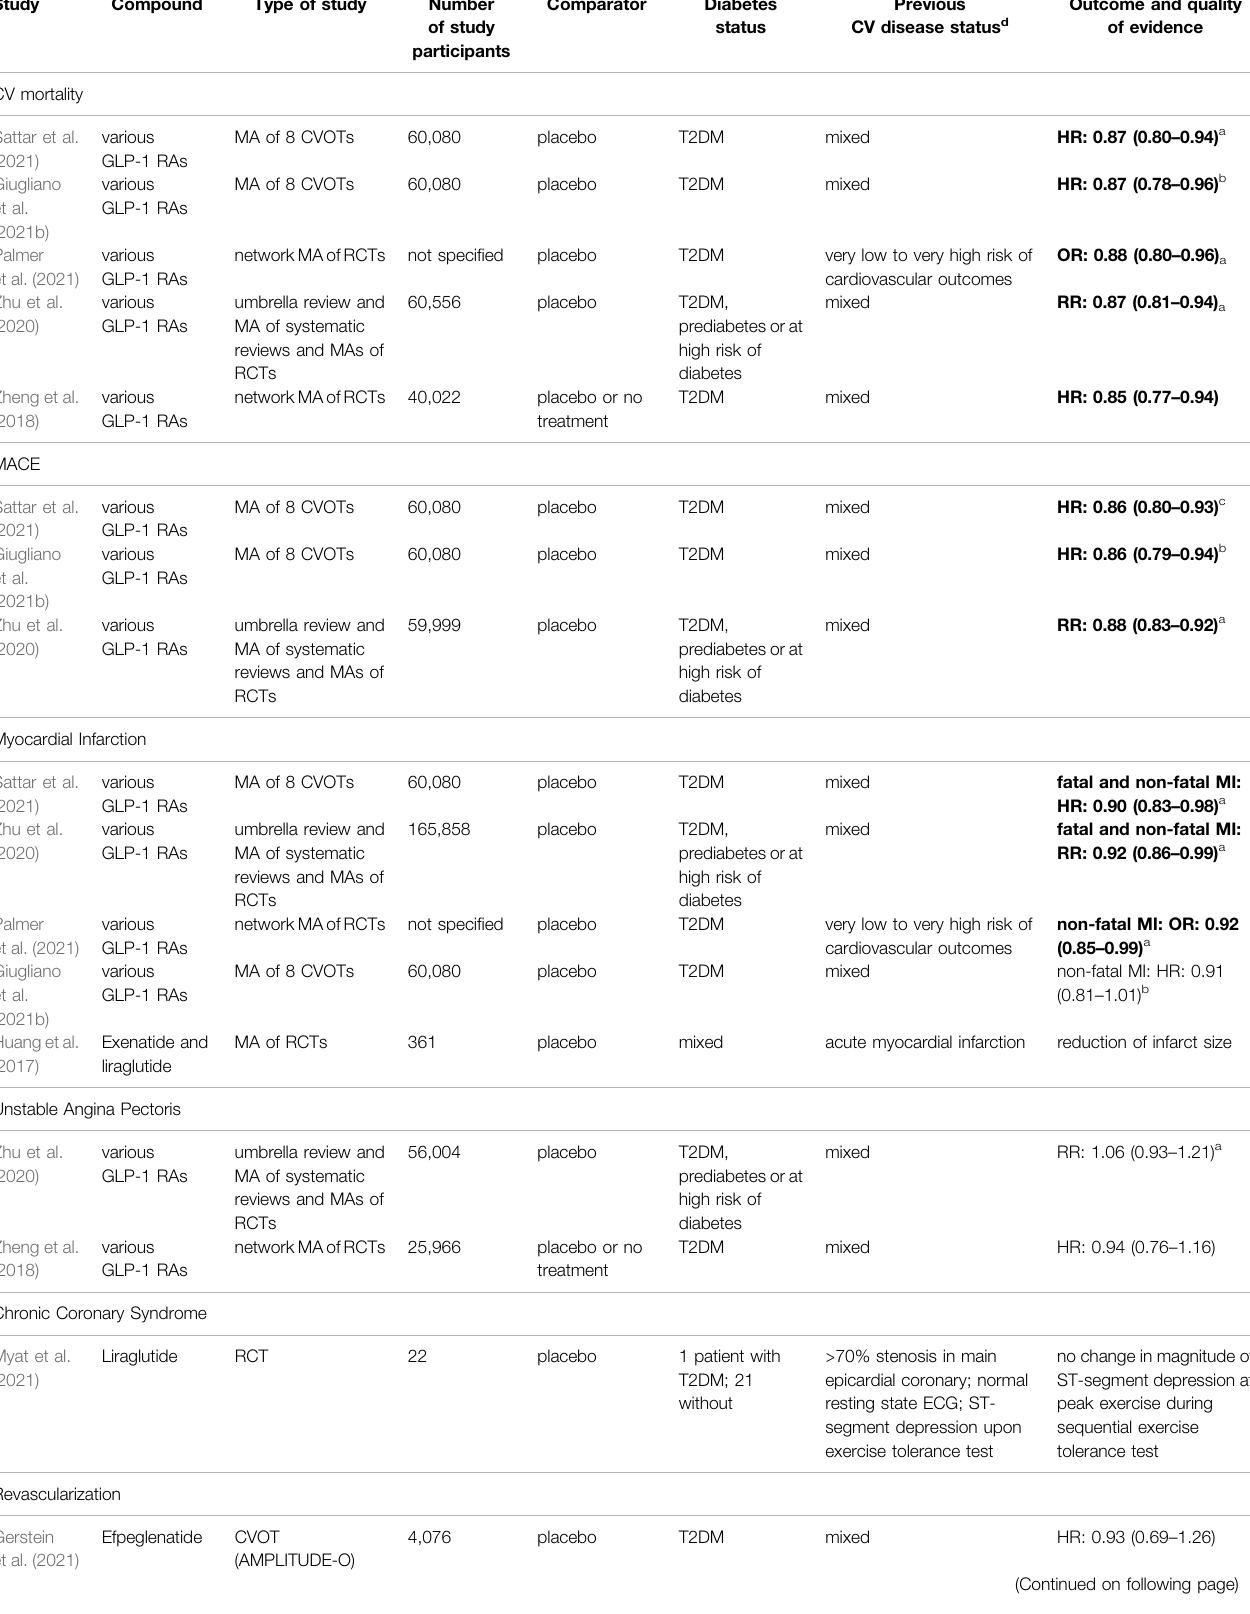
TABLE 2 | Overview of studies reporting on GLP-1 RAs and the risk of coronary